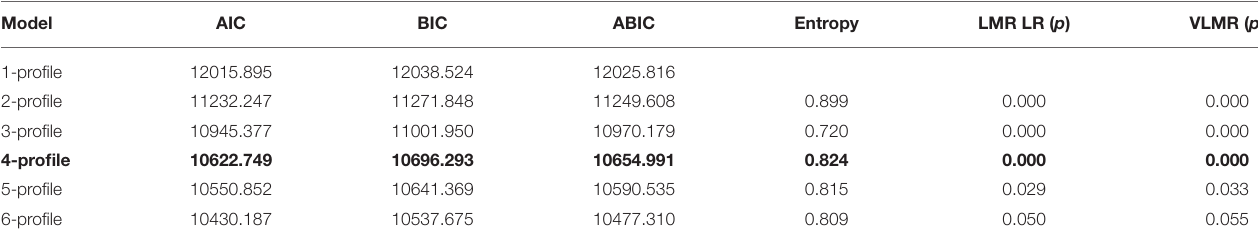
TABLE 2 | Model fit indices for one to six profile solutions of perceived stress.